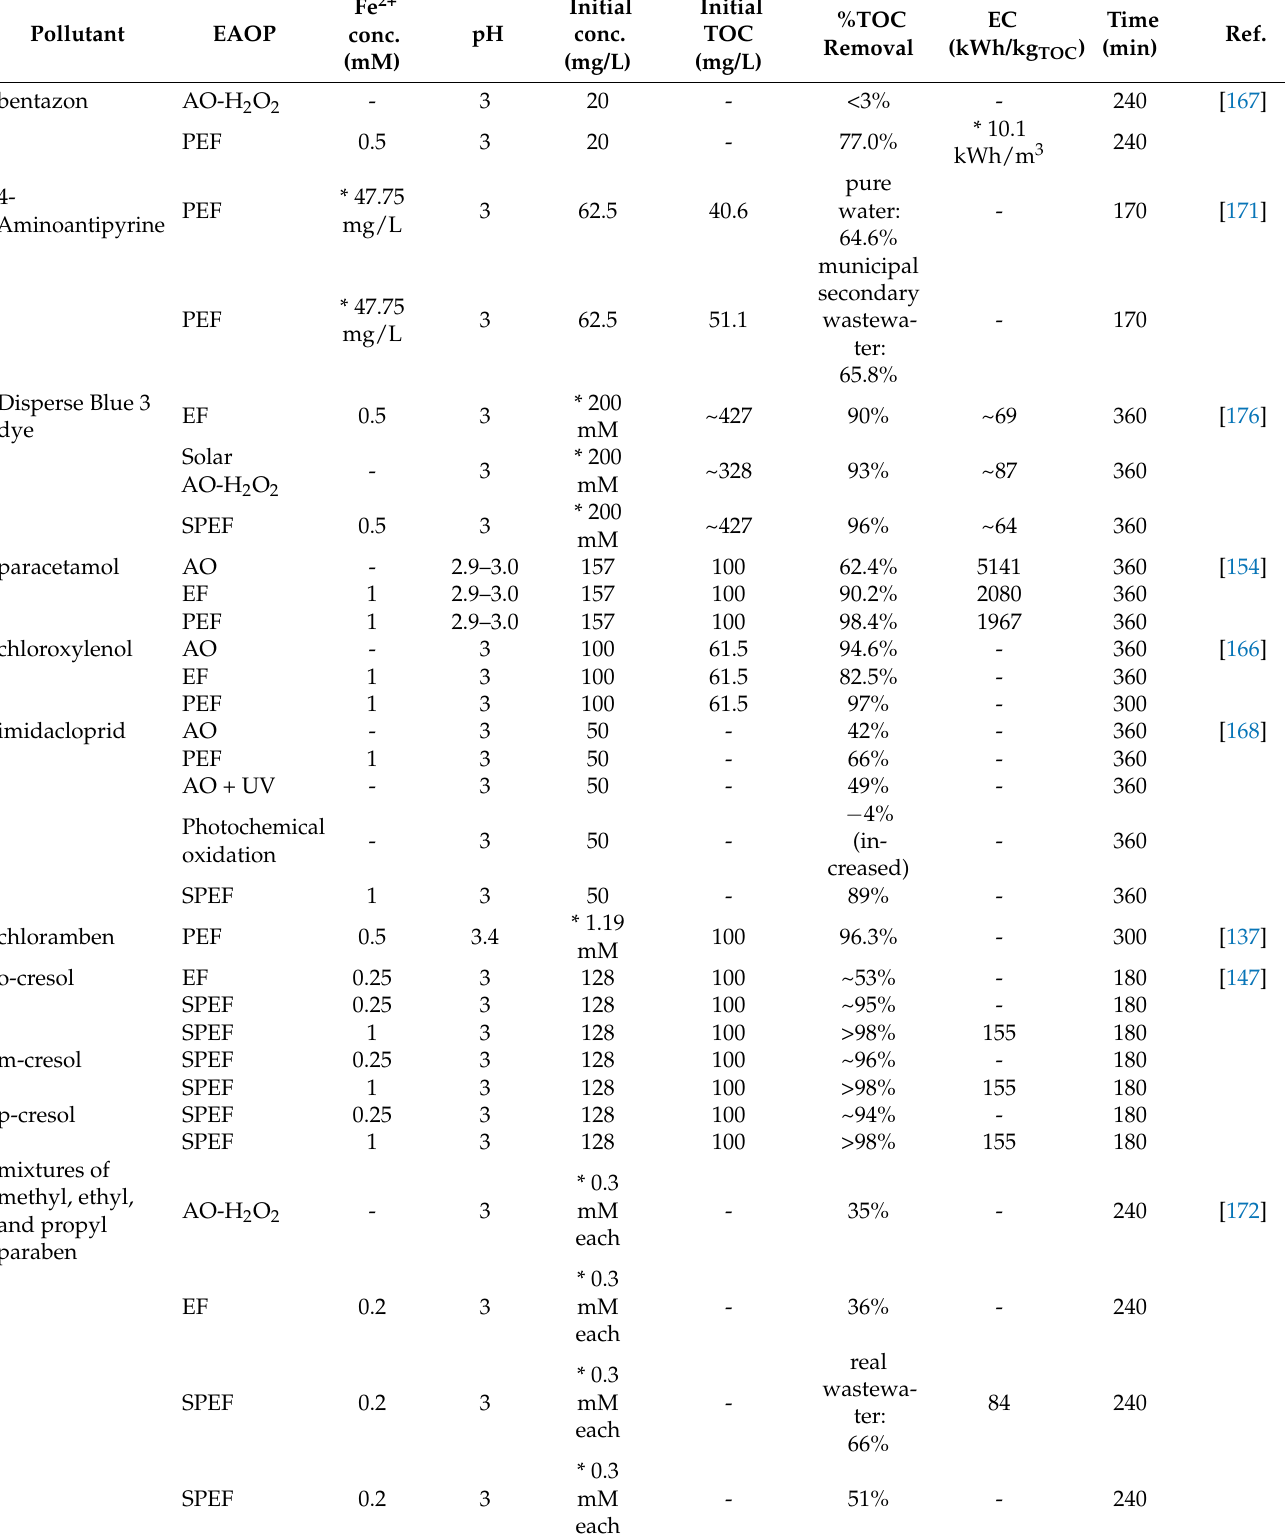
Table 6. Examples of pollutants treated with BDD anodes in photo-enhanced electro-Fenton